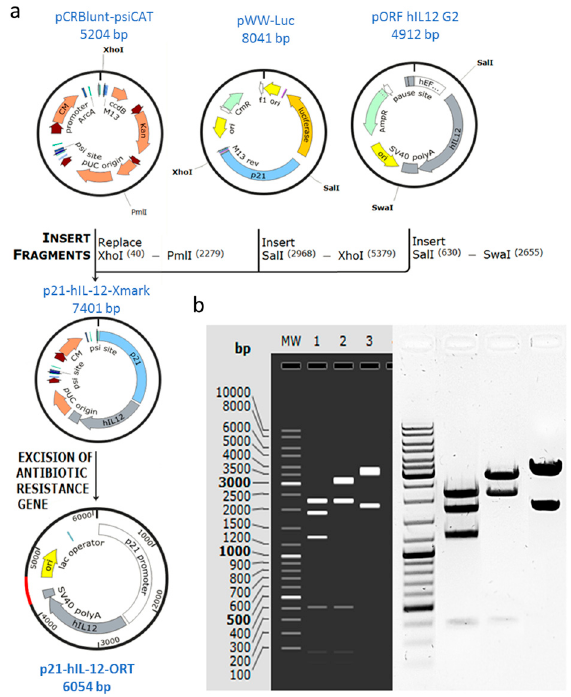
Figure 1. Construction and confirmation of the p21-hIL-12-ORT plasmid: ( a ) Schematic representation of the construction of the p21-hIL-12-ORT plasmid; ( b ) Restriction analysis results after electrophoresis on agarose gel confirming the identity, purity, and concentration of the plasmid. MW: GeneRuler DNAtm DNA Ladder Mix, lane 1: double restriction by HindIII and MunI resulting in 2338, 1925, 1338, 409, 79, and 19 bp bands; lane 2: restriction by HindIII resulting in 3260, 2338, 409, 79 bp, and 19 bp bands; lane 3: restriction by KpnI resulting in 3966 and 2142 bp bands.